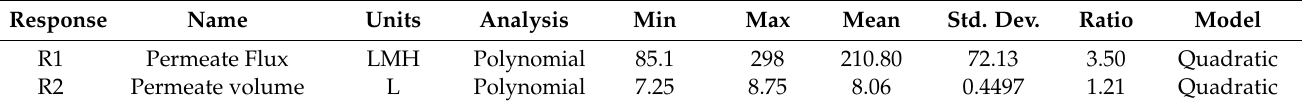
Table 6. Responses